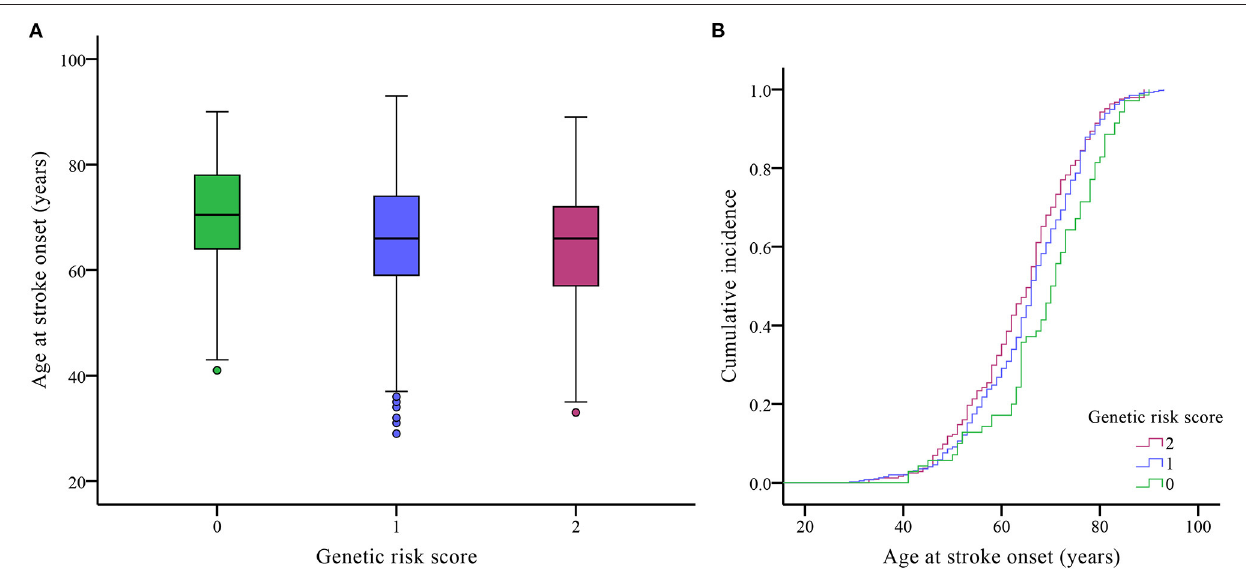
Frontiers in Neurology |